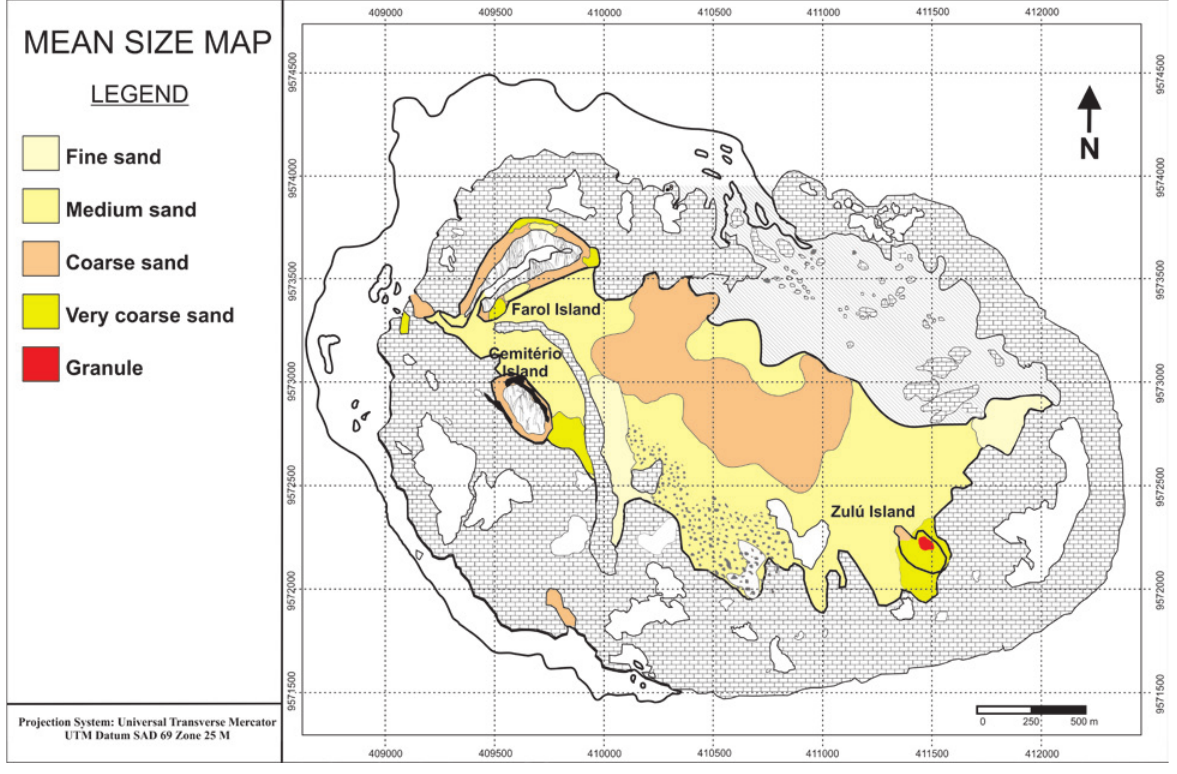
Figure 08 - Mean grain size map of Rocas